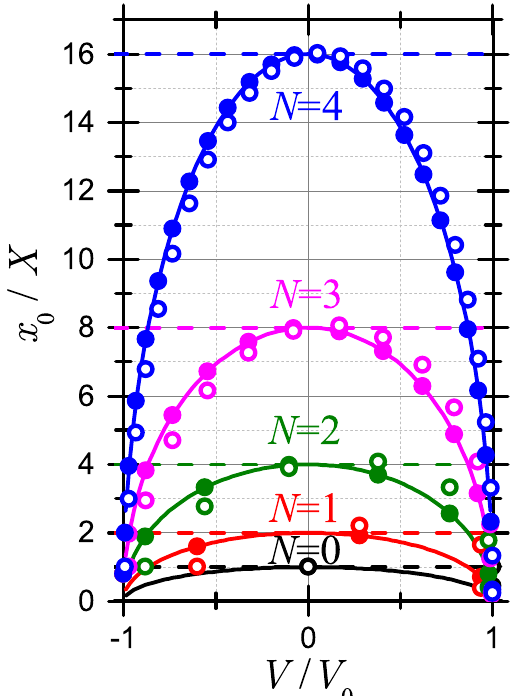
Figure 10. ( V ,1/ X ) portrait for b = 2 and N = 0,1,2,3,4 (from bottom to top). Solid symbols, ball–wall collision; open symbols, ball–ball collision. Solid lines, ellipse (46). Dashed horizontal lines, inverse of the minimal distance